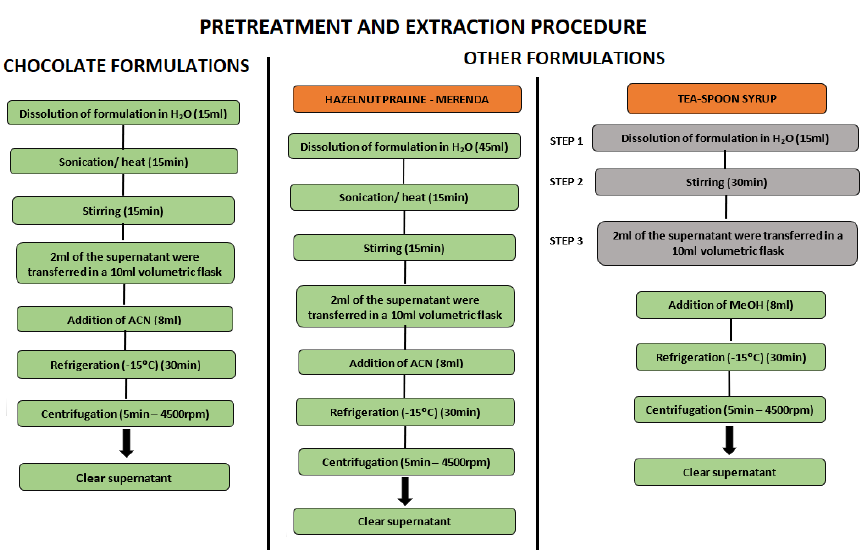
Figure 2. Schematic diagram of sample pre-treatment and extraction efforts.